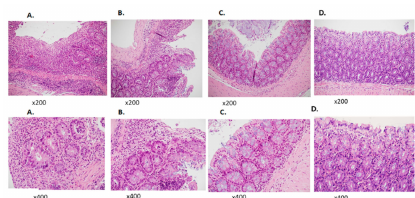
Figure 4. Histological analysis of distal colon sections in chronic colitis mice. Histological analysis: H&E staining in representative distal colon section from each studied group of chronic colitis mice magnification of × 200 and × 400. ( A ) PBS control mice: massive infiltration of lymphocytes, destruction of the normal structure, and cryptitis. Histological score for DSS = 12 points (over 10% loss of epithelium = 3 points, over 20% loss of crypts = 3 points, severe depletion of goblet cells = 3 points, severe infiltration of inflammatory cells = 3 points). ( B ) TPC-treated mice: mild pathology of cryptitis. Histological score for DSS = 6 points (over 10% loss of epithelium = 3 points, 10–20% loss of crypts = 2 points, moderate depletion of goblet cells = 2 points, mild infiltration of inflammatory cells = 1 points). ( C ) TPC-treated mice: No significant infiltration of lymphocytes with no cryptitis. Histological score for DSS = 0 points (no loss of epithelium = 0 points, no loss of crypts = 0 points, no depletion of goblet cells = 0 points, no infiltration of inflammatory cells = 0 points). ( D ) Normal healthy